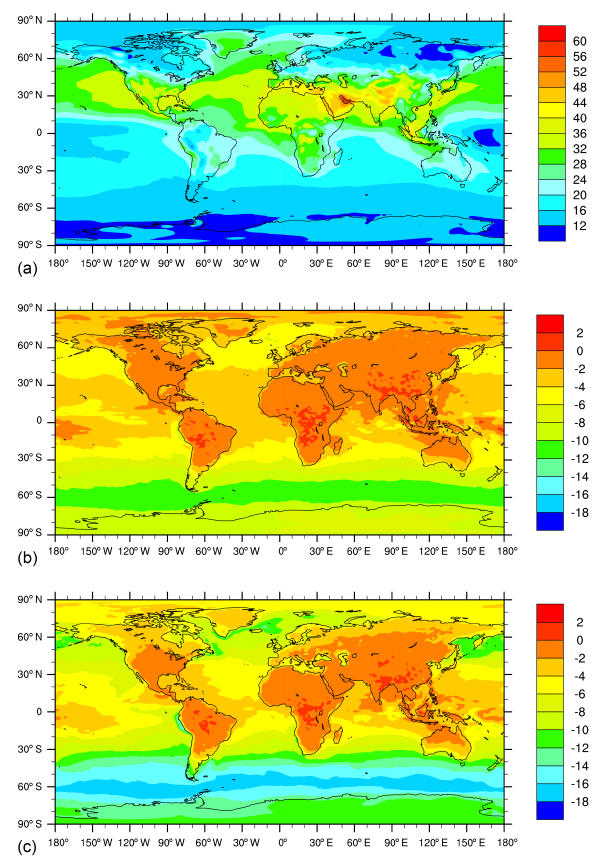
Figure 11. (a) Modelled annual ozone concentration (ppbv) for 2006 obtained using the two-layer reactivity scheme; (b) average relative difference (%) between the ozone concentration predicted using the one-layer reactivity scheme and the two-layer reactivity scheme; and (c) average relative difference (%) between the ozone concentration predicted using the default scheme with surface resis- tance r c = 2200sm − 1 and the two-layer reactivity